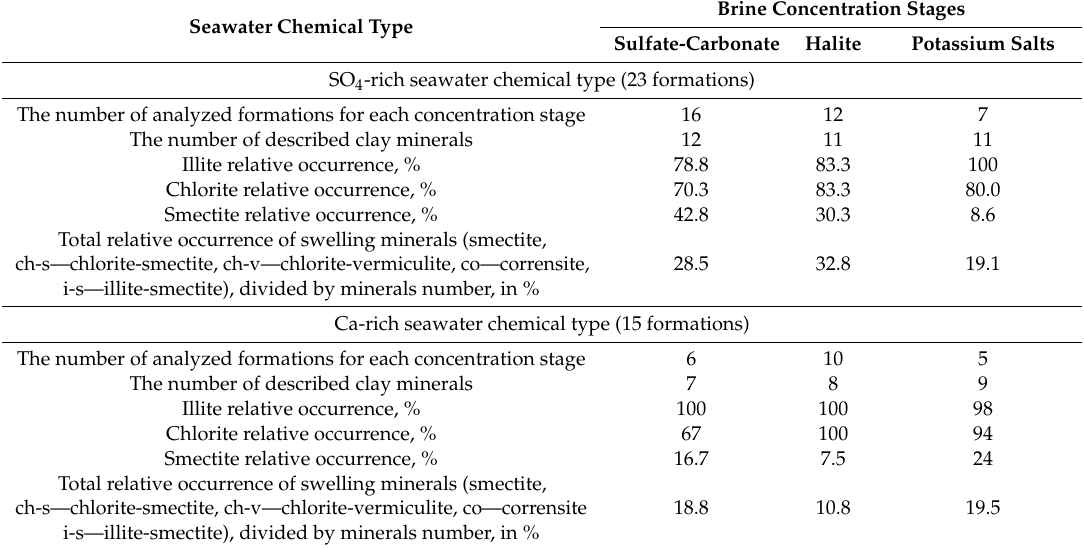
Table 2. Relative occurrence of most common clay minerals in Phanerozoic marine evaporite formations at di ff erent stages of brine